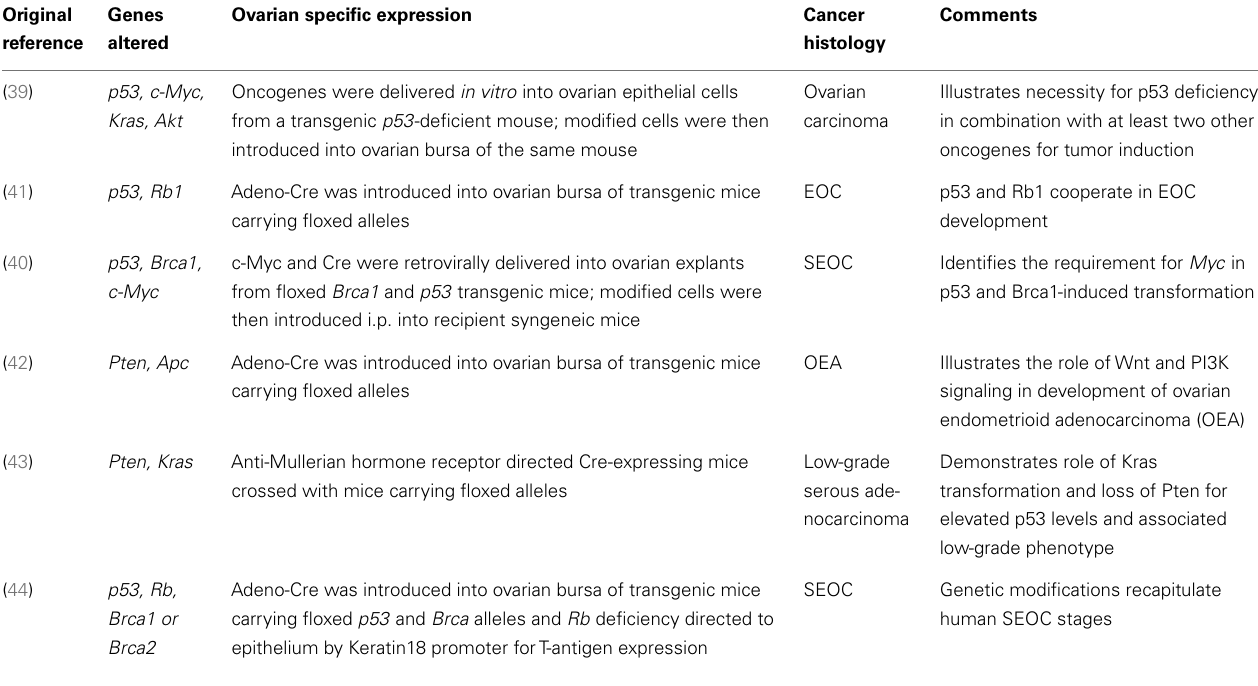
Table 1 | GEMMs for ovarian